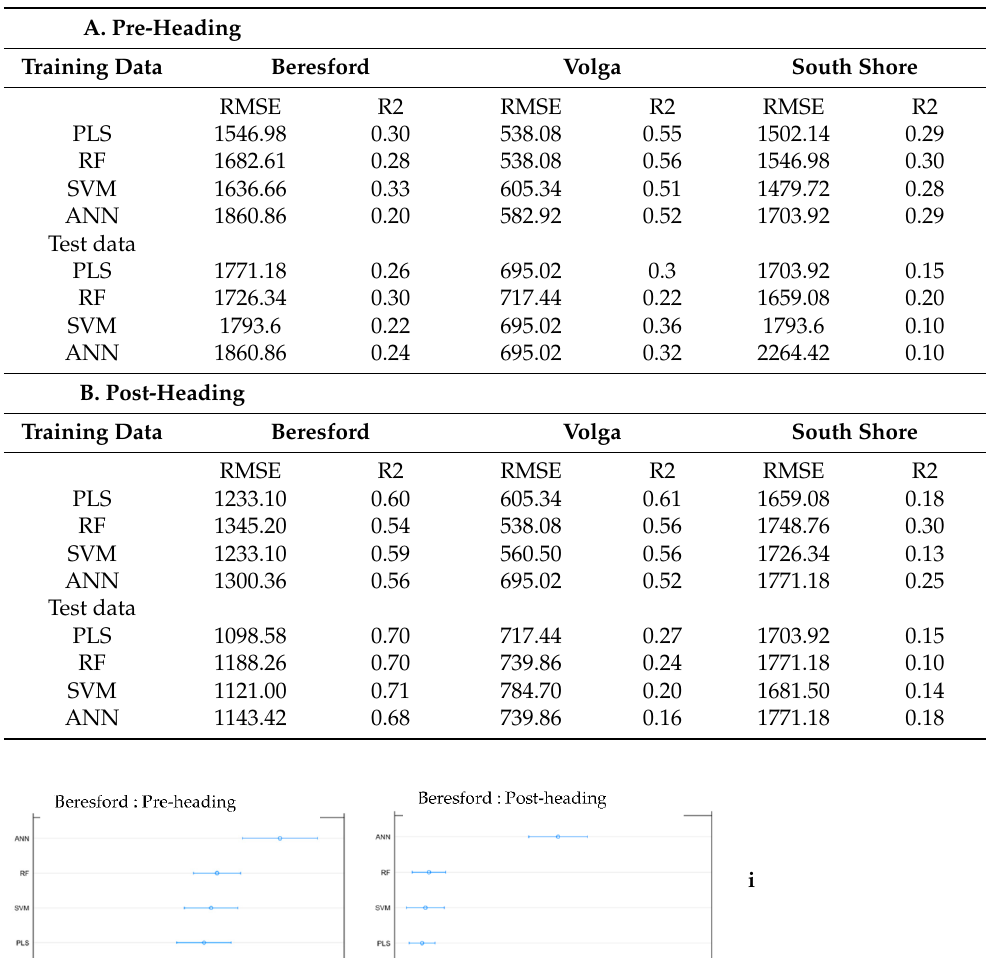
Table 6. Performance of prediction models for dry matter yield in oats based on VIs derived from imagery collected pre- and post-heading (A and B) using RGB and multispectral sensors.